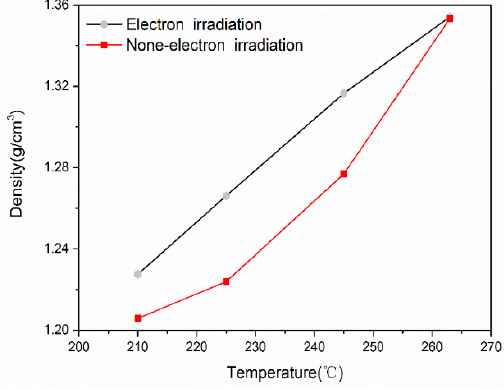
Figure 4. Densities of PAN and irradiated PAN fiber after each stage of stabilization.